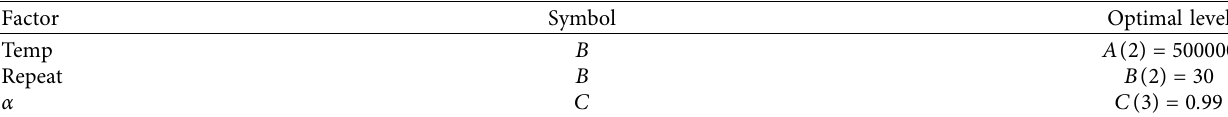
Table 9: Optimum levels of SA parameters in medium size instances.